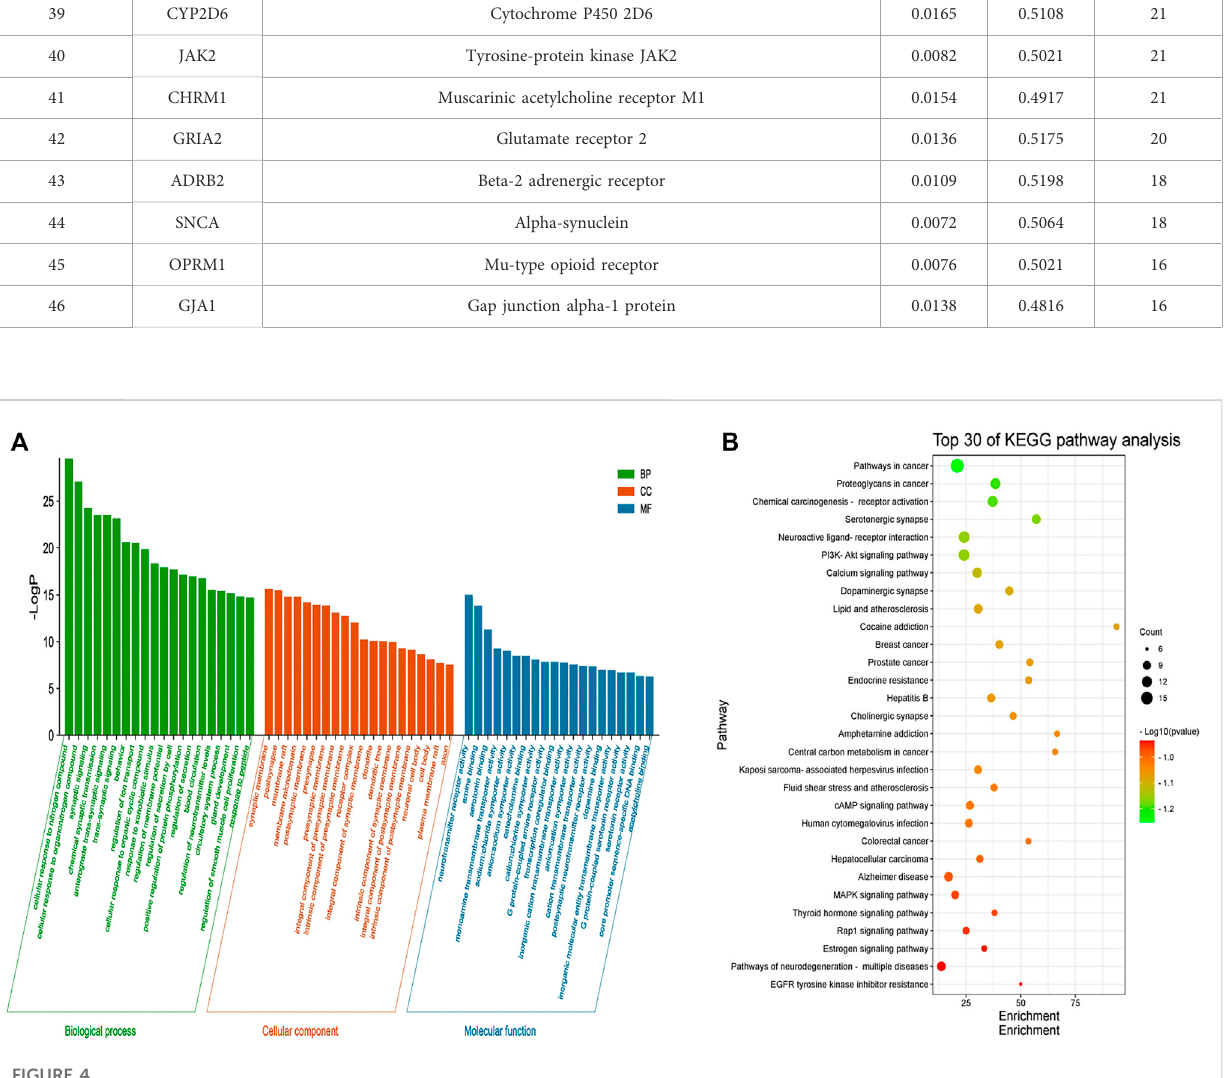
FIGURE 4 (A) GO enrichment analysis of the core targets of LMQXM for ADHD. The green bar chart denotes the bio-logical process (BP) enrichment analysis, theredbarchartdenotesthecellcomposition(CC)enrichmentanalysis,andthebluebarchartdenotesthemolecularfunction(MP)enrichmentanalysis. The horizontal axis represents the name of the enrichment analysis, the vertical axis represents the negative value of LogP. The smaller the -LogP value, the more signi fi cant the enrichment of the differential genes (B) The top 30 pathways of KEGG enrichment analysis of LMQXM for ADHD. The abscissa represents the size of the enrichment, the ordinate represents the enriched pathway, the size of the bubble represents the number of genes in the pathway, and the color of the bubble from green to red represents the p -value from small to